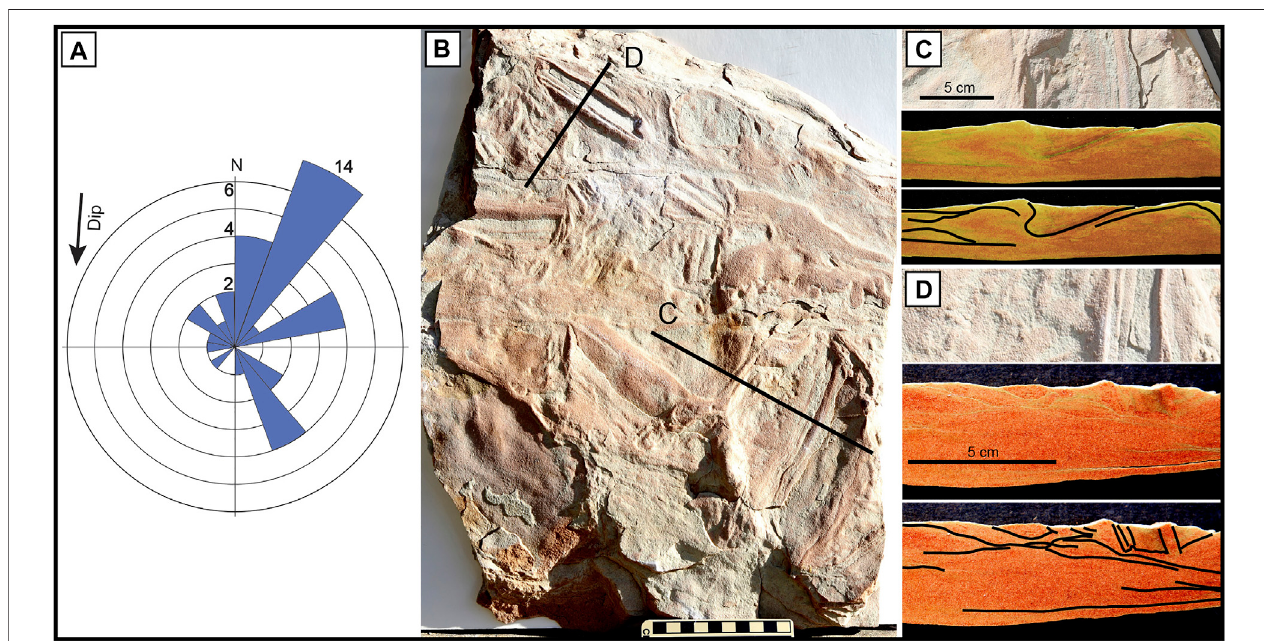
FIGURE9|(A) isarosediagramshowingthecompassdirectionsoftheupperedgeofrotatedblocks.Arrowindicatestheaveragedipdirectionofthecross-beds. (B – D) is a sample with several rotated blocks and deformation features. Photo (B) is a surface view of the structures, with lines indicating the locations of the cross- sections in photos (C,D) . This sample does not show the distinct horizontal truncation that is evident at the top surface in other samples of rotated blocks.